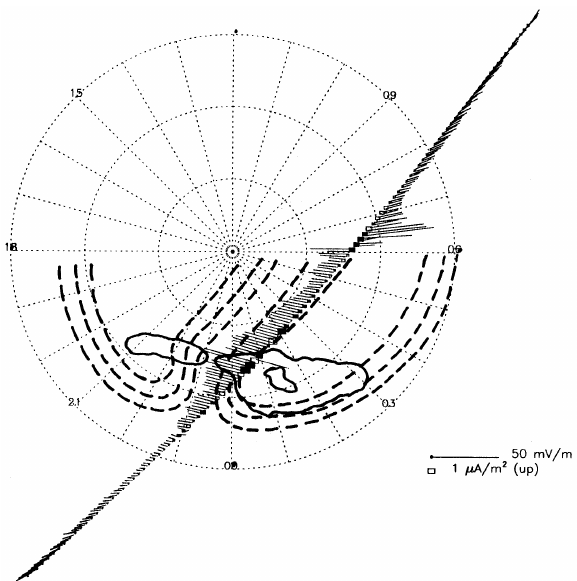
Fig. 7. Summary of the observations. The electric and magnetic field data along the footpoint of the Astrid-2 orbit are represented by electric field vectors and by calculated upward and downward field-aligned currents (open and solid squares, respectively). The dotted lines represent equipotential contours that are consistent with the Astrid-2 and STARE electric field data and with the directions of the electrojets inferred from the magnetometer data on Greenland, Svalbard, Bjørnøya and northern